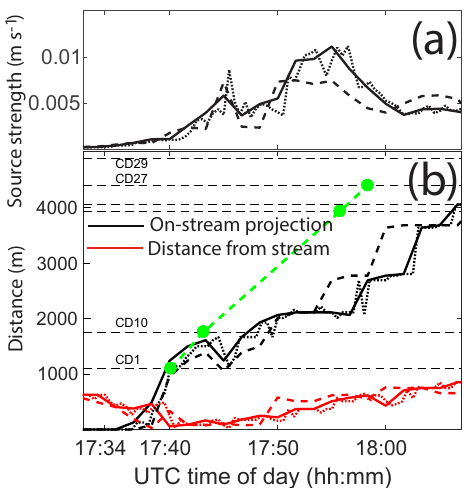
Figure 10. Source strength of the debris-flow seismicity (a) and best-fit source locations (b) . Solid line represents the ASL method applied to 100s windows without site amplification correction. Dashed line represents the calculation with site amplification. Dot- ted line shows the results for 30s windows, again without site am- plification. In (b) , black lines show the best-fit locations projected onto the along-flow coordinate system of the stream with a man- ually picked point in the upper catchment indicating the channel head. Red lines show the shortest distance of the best-fit location from the stream bed. Green dots connected by dashed lines indicate check dam arrival times (labels of check dams 24 and 25 are omitted for clarity).